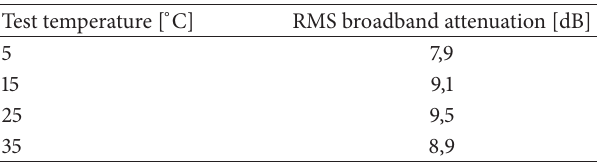
Table 2: VDVN performance (vibration attenuation), broadband